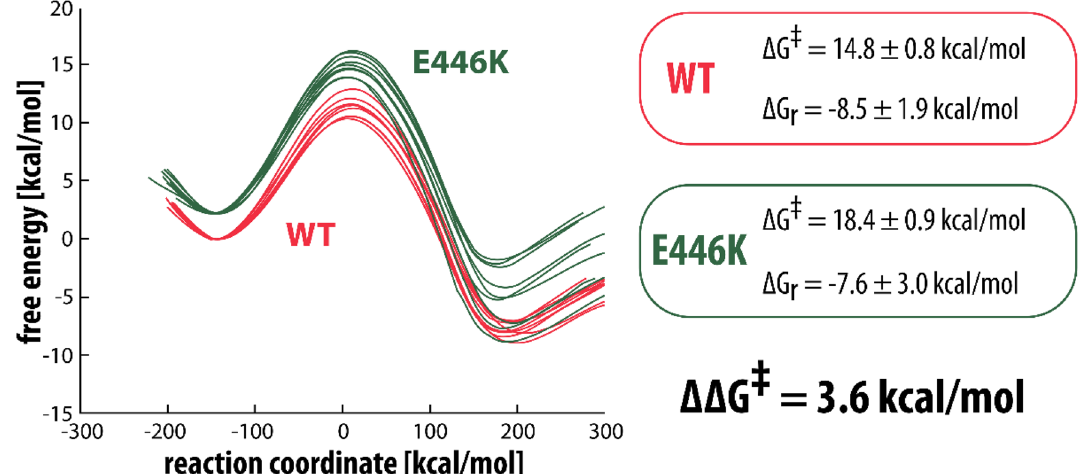
Figure 4. Free energy profiles for the rate-limiting step reaction between serotonin and the flavin cofactor in WT (red) and in E446K mutant (green). The free energy barrier and the reaction free energy are also listed for both WT and E446K, with corresponding standard deviations. In the E446K profiles deprotonation correction for Lys446 is included by considering the pKa value of Lys of 8.95, which at physiological conditions (pH = 7.4) converts into a free energy cost of 2.1 kcal/mol.